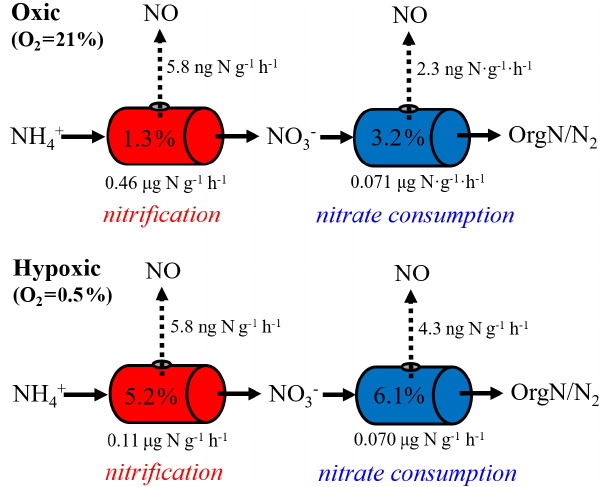
Figure 9. Hole-in-the-pipe illustration of NO production from gross nitrification and NO − consumption under oxic and hypoxic condi- 3 tions. “OrgN” denotes organic